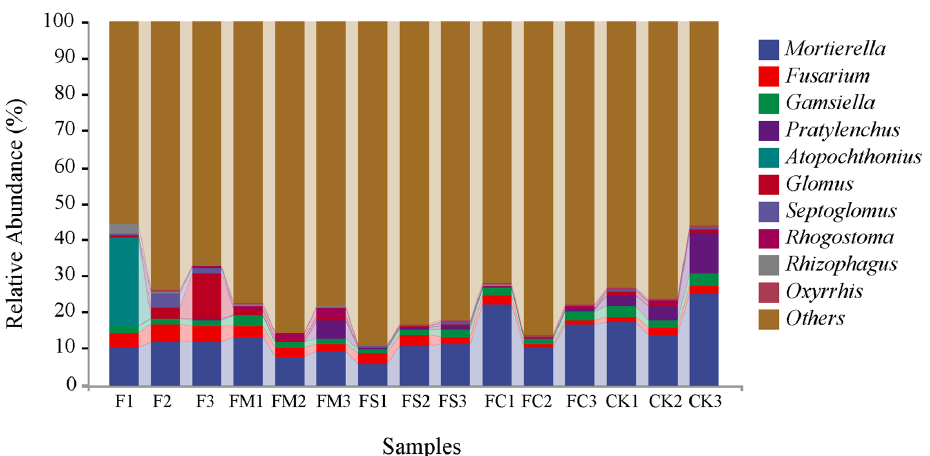
Figure 3. Relative abundance of eukaryotic microorganisms at genus level in different samples.